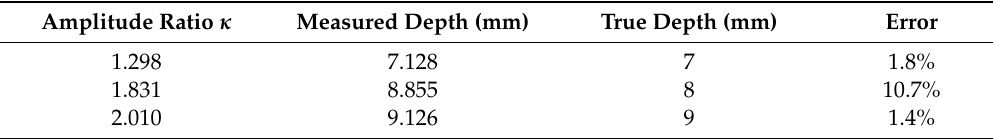
Table 1. Notch depth sizing results for the rectangular notches with di ff erent